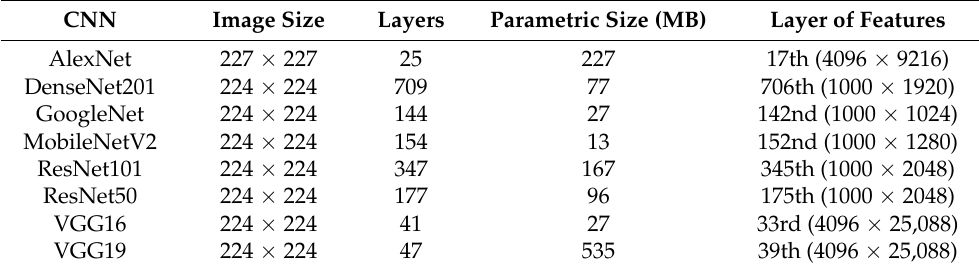
Table 2. Information on the adopted convolutional neural networks. CNN Image Size